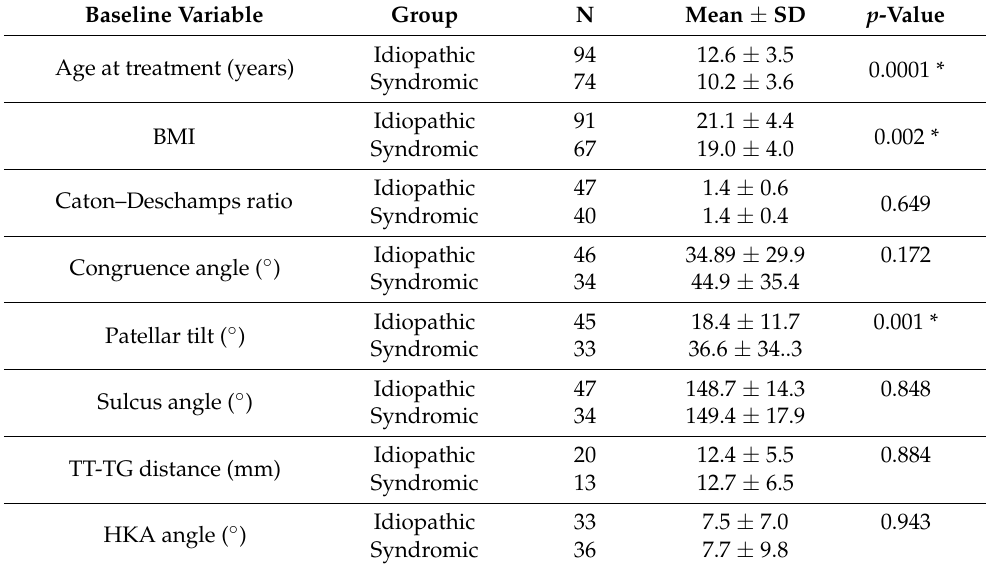
Table 3. Differences in baseline clinical and radiographic variables between idiopathic and syn- dromic